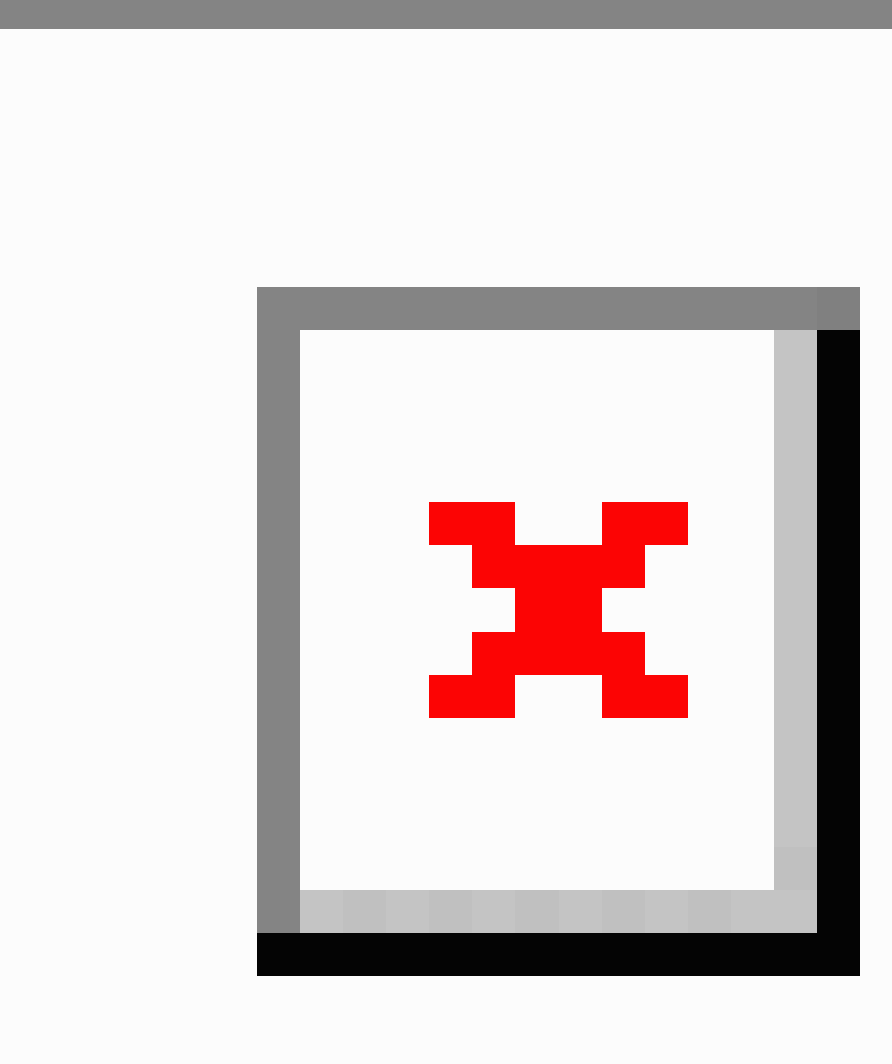
Figure 1. CONSORT diagram: participant flow and